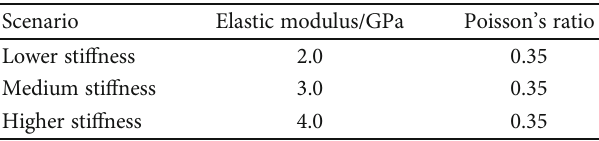
Figure 8: Permeability evolution of primary production and CO Table 4: Numerical simulation